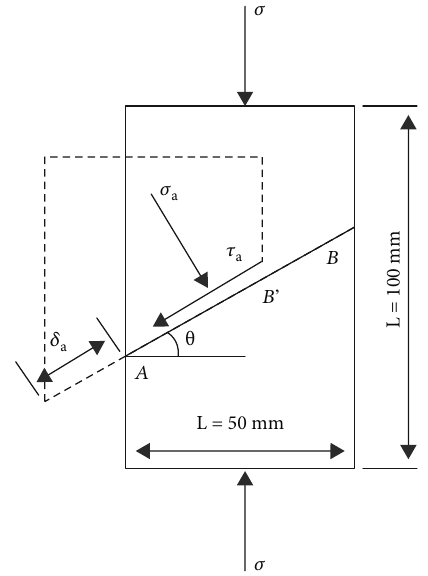
Figure 15: Physical model of grouting with one through-crack